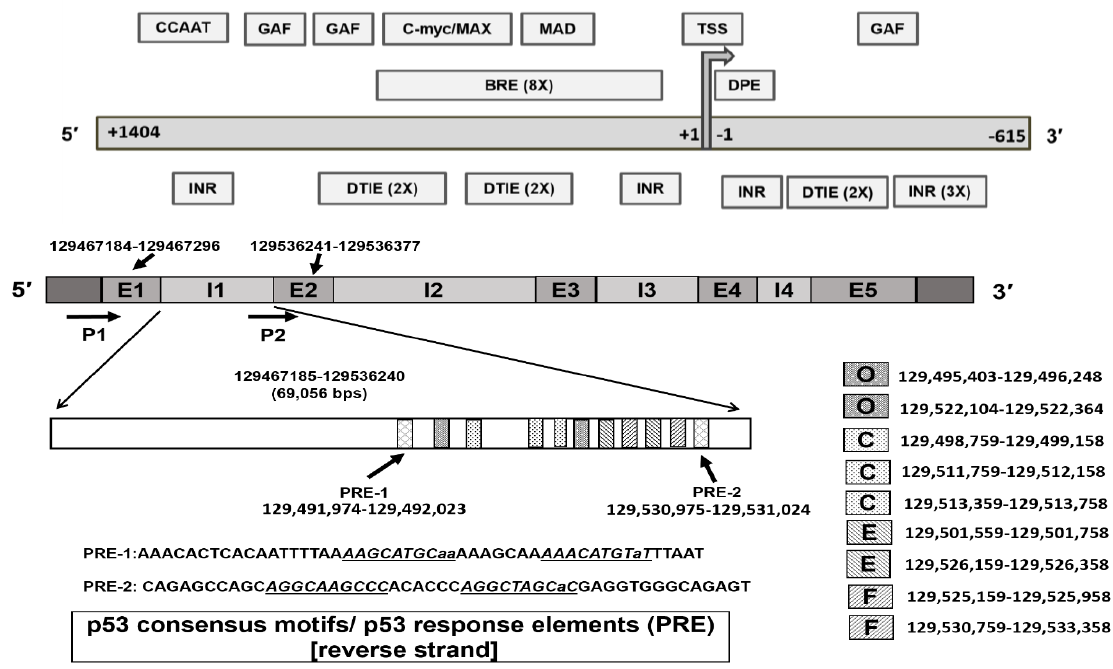
Figure 4. Upper panel—Locations of transcription factor binding motifs of genetic switch c-myc/MAX/MAD and transcrip- tion pausing factor (GAF) in the MGMT-P1 revised promoter. BRE, B Recognition Element, DTIE, initiator of TATA-box minus transcription, INR, Initiator Element. Lower panel—Presence of p53 response elements (PREs) in the MGMT intron-1. The base pairs of PREs that perfectly conform to the p53 consensus motif are shown in underlined italic capital letters. The base-pair variations of the p53 consensus motif are shown in small letters. Key: Exon (E)), Intron (I), Open chromatin (O), CTCF (C), Enhancer (E), Promoter flank (F), Promoter (P). RRRCWWGYYY (N) RRRCWWGYYY, where R=A or G; W=A or T; Y=C or T; N (0–13) = A, T, C or G.